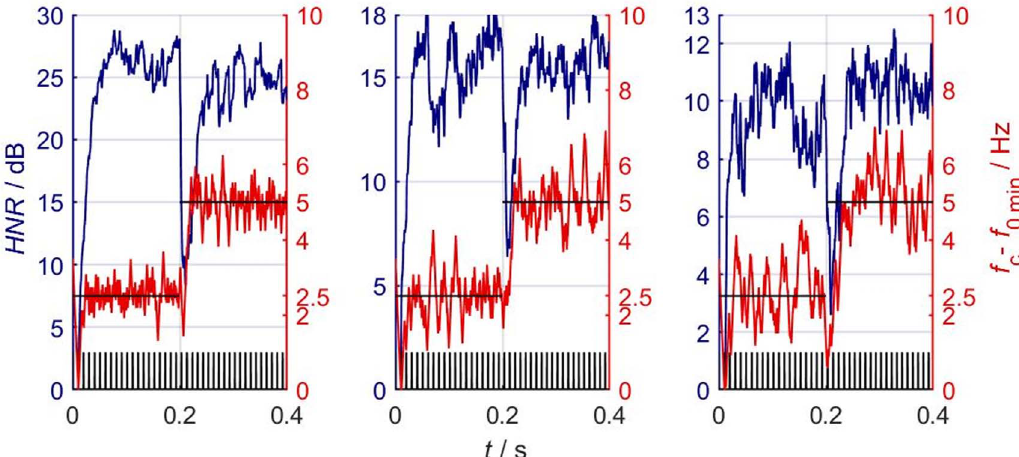
Figure 3. Simulation I: Complex tone with a fi xed fundamental frequency of 98.5 Hz (1st half) and 101.0 Hz (2nd half), SNR is 21.5 dB, 7.5 dB and 1.5 dB (left, center and right panel). Each panel shows the PM-HLL oscillator frequency (i.e., fundamental frequency estimate) f c referenced to 96 Hz (red curve, right scale), the HNR (blue curve, left scale) and the strobe points (black bars), as a function of time. The black line shows the signal ’ s fundamental frequency trajectory. Data show quick convergence and small estimation variance even at the lowest SNR. The HNR depends on SNR and quickly goes low during loop adaptation, thus indicating the unlocked state.